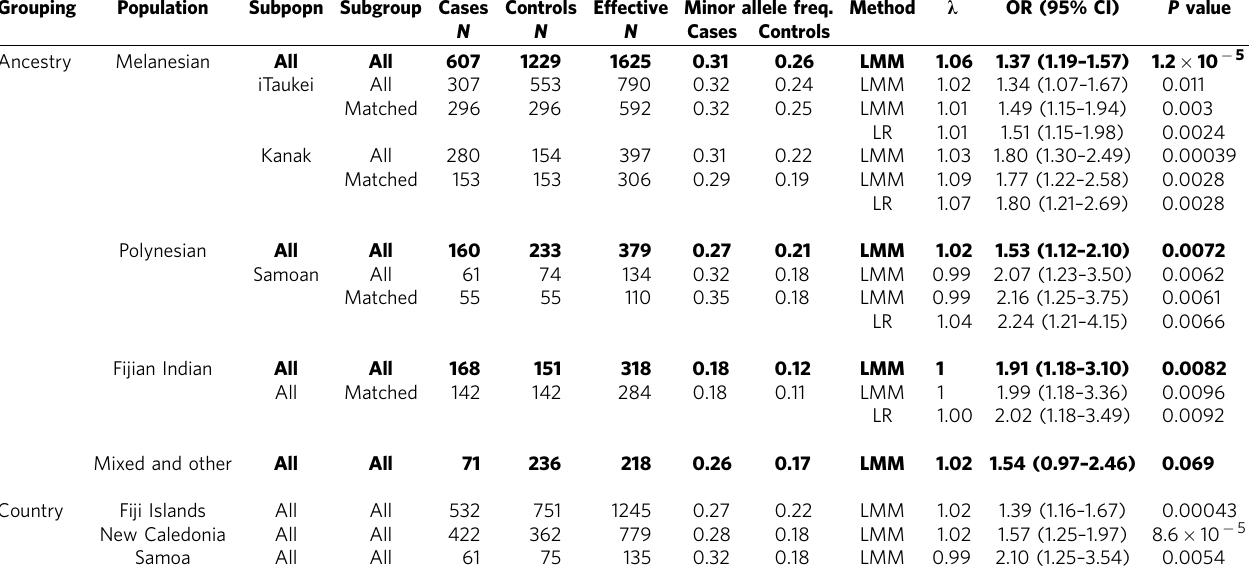
Table 1 | Association of the IGHV4-61 *02 allele with RHD susceptibility by ancestry and country. Grouping